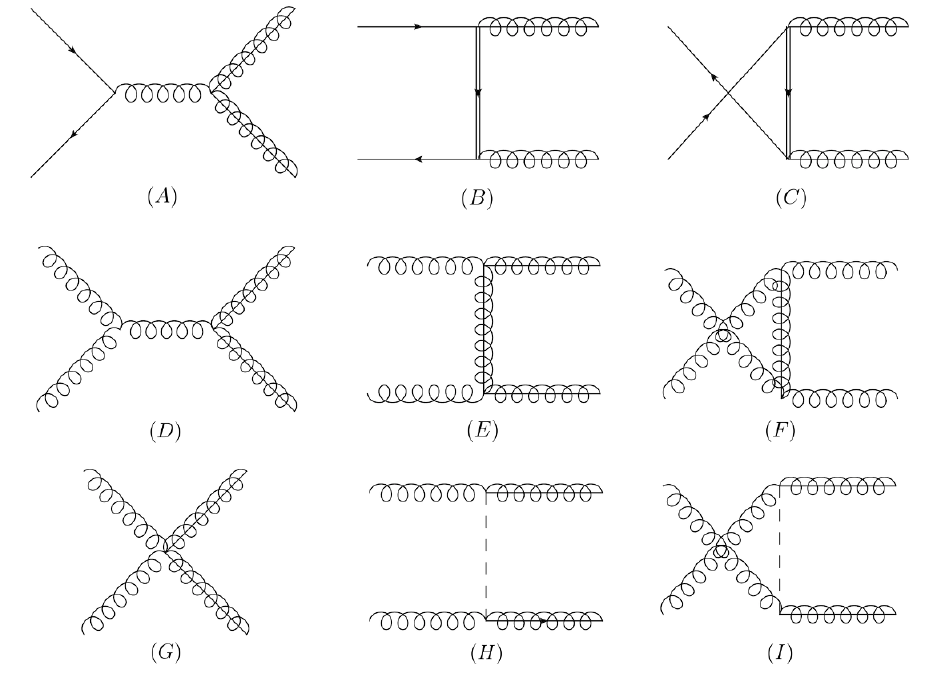
Figure 1 . Born-level diagrams contributing to massive color-octet vector-boson pair production. Here the spring-solid lines indicate massive color-octet vector-bosons, while the double lines indicate massive P -odd quarks, and the dashed line indicates a P -odd Goldstone